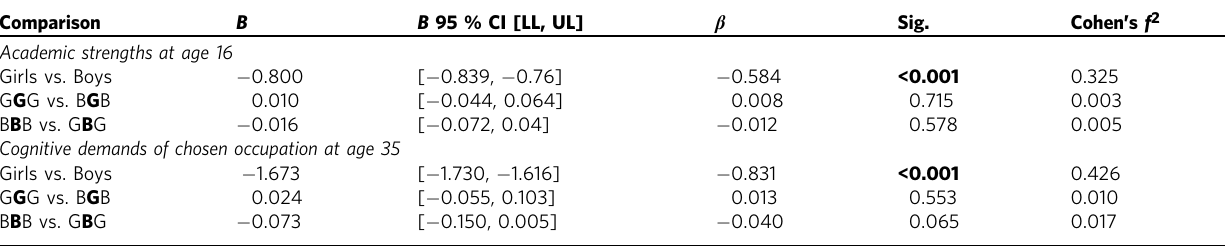
Table 2 Regression table summarizing the differences in academic strengths and cognitive demands of chosen occupation grouped by sex (across sexes) and sibship composition (within sexes) in Study